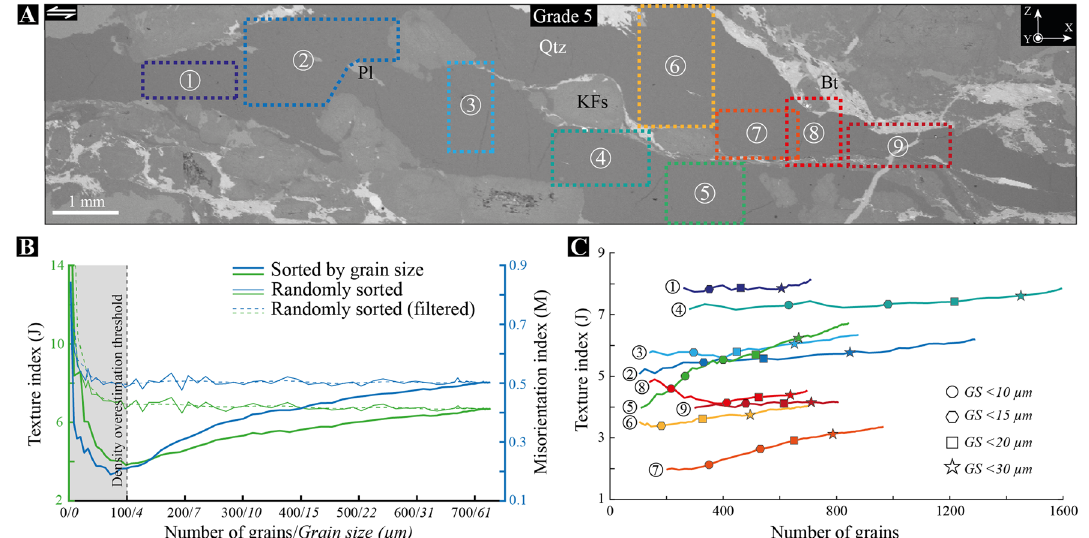
Figure 8. Texture strength dependency on grain size (continued). ( A ) BSE image of a shear band in grade 5 where nine EBSD maps are located (EBSD maps are available in Supp. Fig. 5). X Shear direction; Y cardinal axis; Z pole to shear plane; KFs K-feldspar; Qtz quartz; Pl Plagioclase. ( B ) Texture (J) and misorientation (M) indices versus number of grains/grain size extracted from the EBSD map #5 and located in ( A ). J and M are calculated for a cumulative number of grains either sorted by ascending grain size or randomly selected in the same dataset (randomly sorted). This graph exemplifies our procedure to define the threshold number of grains (here 100 grains) above which J and M are relevant, i.e., independent on density overestimations (see the ‘Method’ section). The dashed line refines the threshold value by applying a zero-phase digital filtering to J and M based on randomly sorted data. ( C ) Texture (J) index versus number of grains extracted from all maps shown in ( A ). J is calculated for a cumulative number of grains sorted by ascending grain size. Only data above the density overestimation threshold have been considered. Symbols give the J index and number of grains for grain size (GS) populations lower than 10, 15, 20 and 30 μm. While most EBSD maps highlight a positive dependency of the fabric strength on grain size, this dependency weakens or even disappears for some of them (see